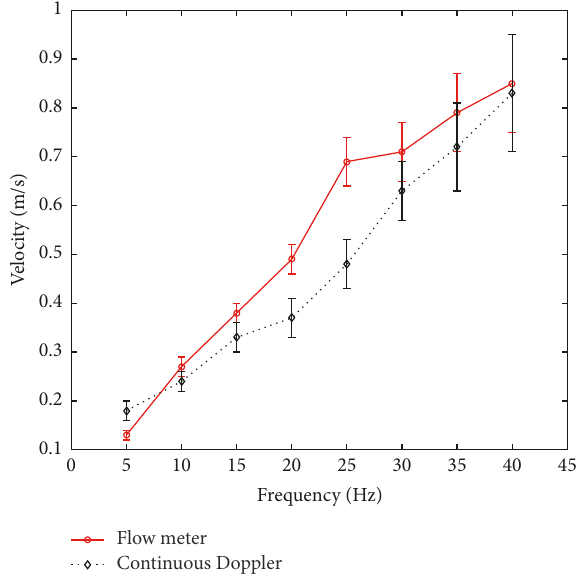
Figure 19: Comparison between the proposed method and the target flow